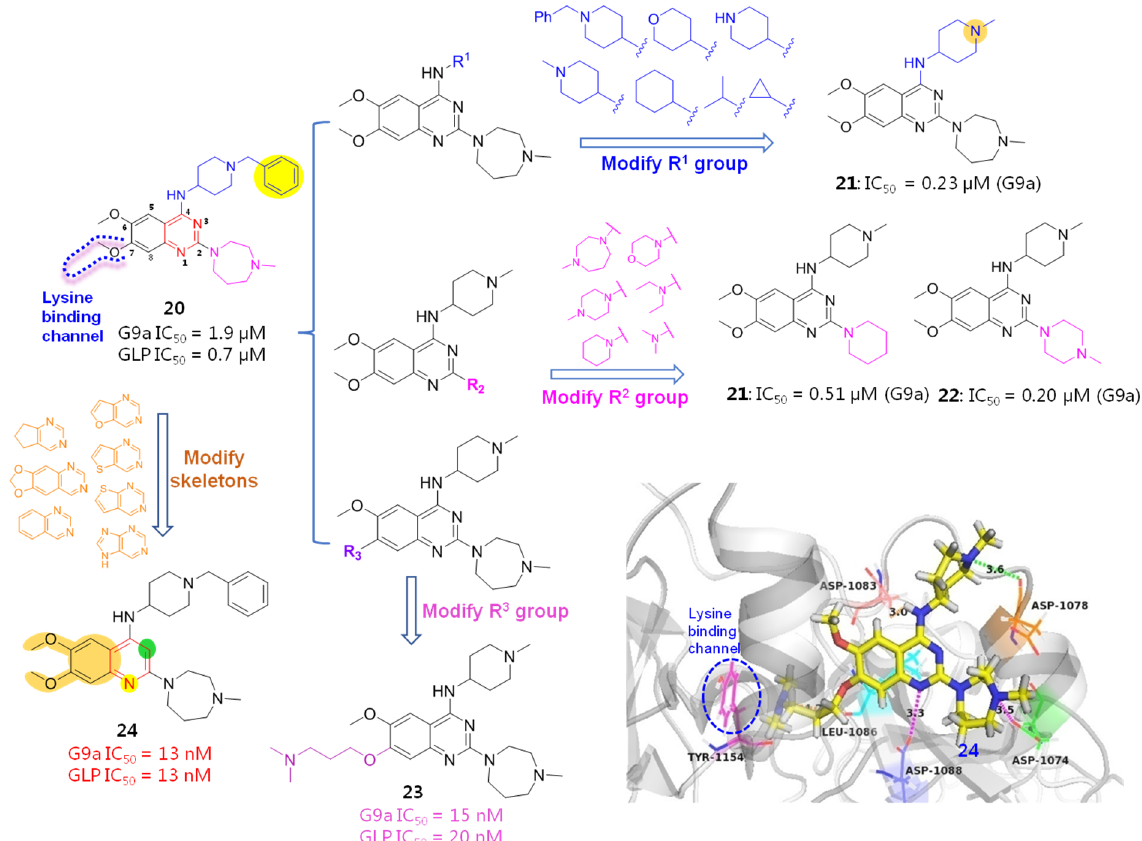
Figure 7. Structure-based modifications based on BIX01294 (20) led to more potent HMTIs, 24 and 25, and the binding pattern of 24 with G9a was also presented.